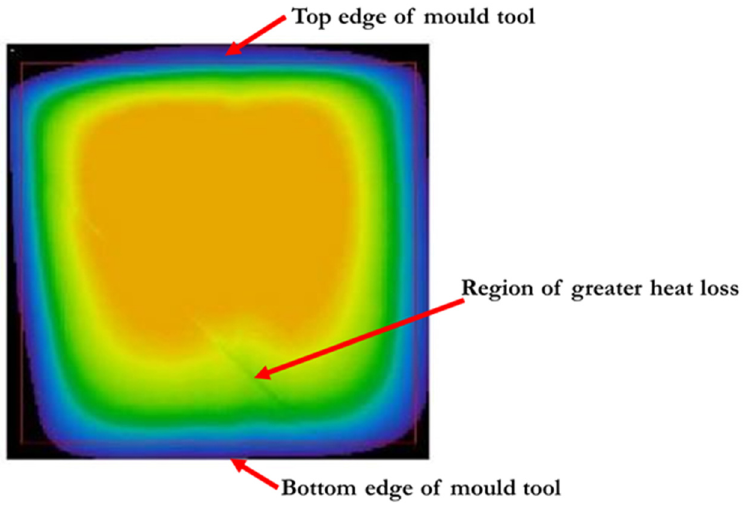
Figure 9. Thermal imaging of mould tool surface (acquired with permission from [18]).